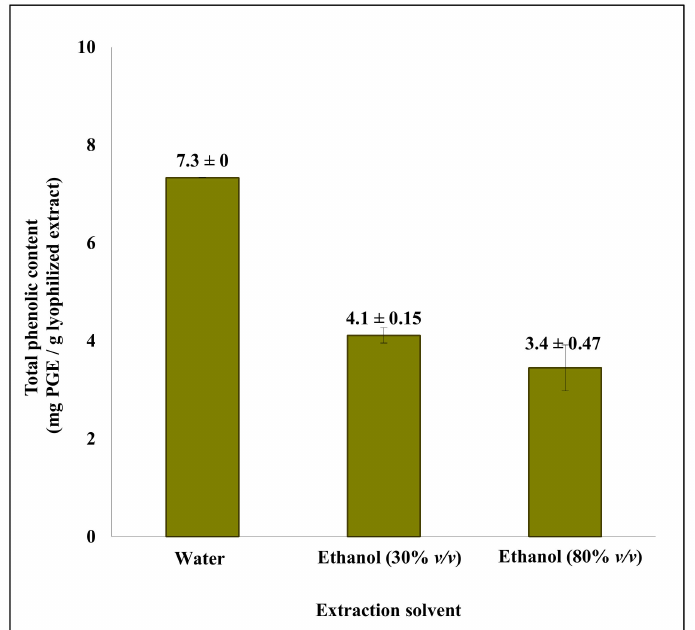
Figure 1. Total phenolic content (TPC) of lyophilized crude extracts (1 g/L) from solvent extraction of S. latissima . Solid:liquid ratio was (1:100) for extraction by water, (1:5) for extraction by aqueous ethanol (30% v / v ), and (1:10) for extraction by aqueous ethanol (80% v / v ). The results were ob- tained as milligrams of phloroglucinol equivalents (PGEs) per gram extract. Data are mean ± SD corresponding to two experimental